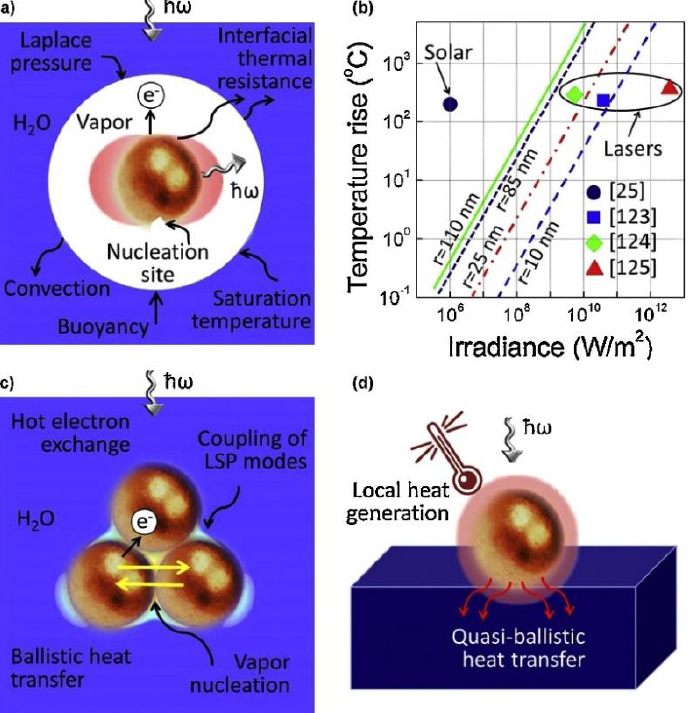
Figure 4. The mechanism of conversion of light to heat using plasmonic NPs: ( a ) Evaporation of water around a metallic NP due to the generation of a localized surface plasmon by photons; ( b ) Relationship between the degree of temperature increase for an Au NP and the irradiance of different wavelengths of light. Labels represent the size of the used gold NPs; ( c ) The thermal and optical interactions between different particles in a plasmonic MD unit; ( d ) Local heat generation in NPs smaller than the phonon mean free path in a substrate material. Reprinted with permission from [133]. Copyright © 2013,